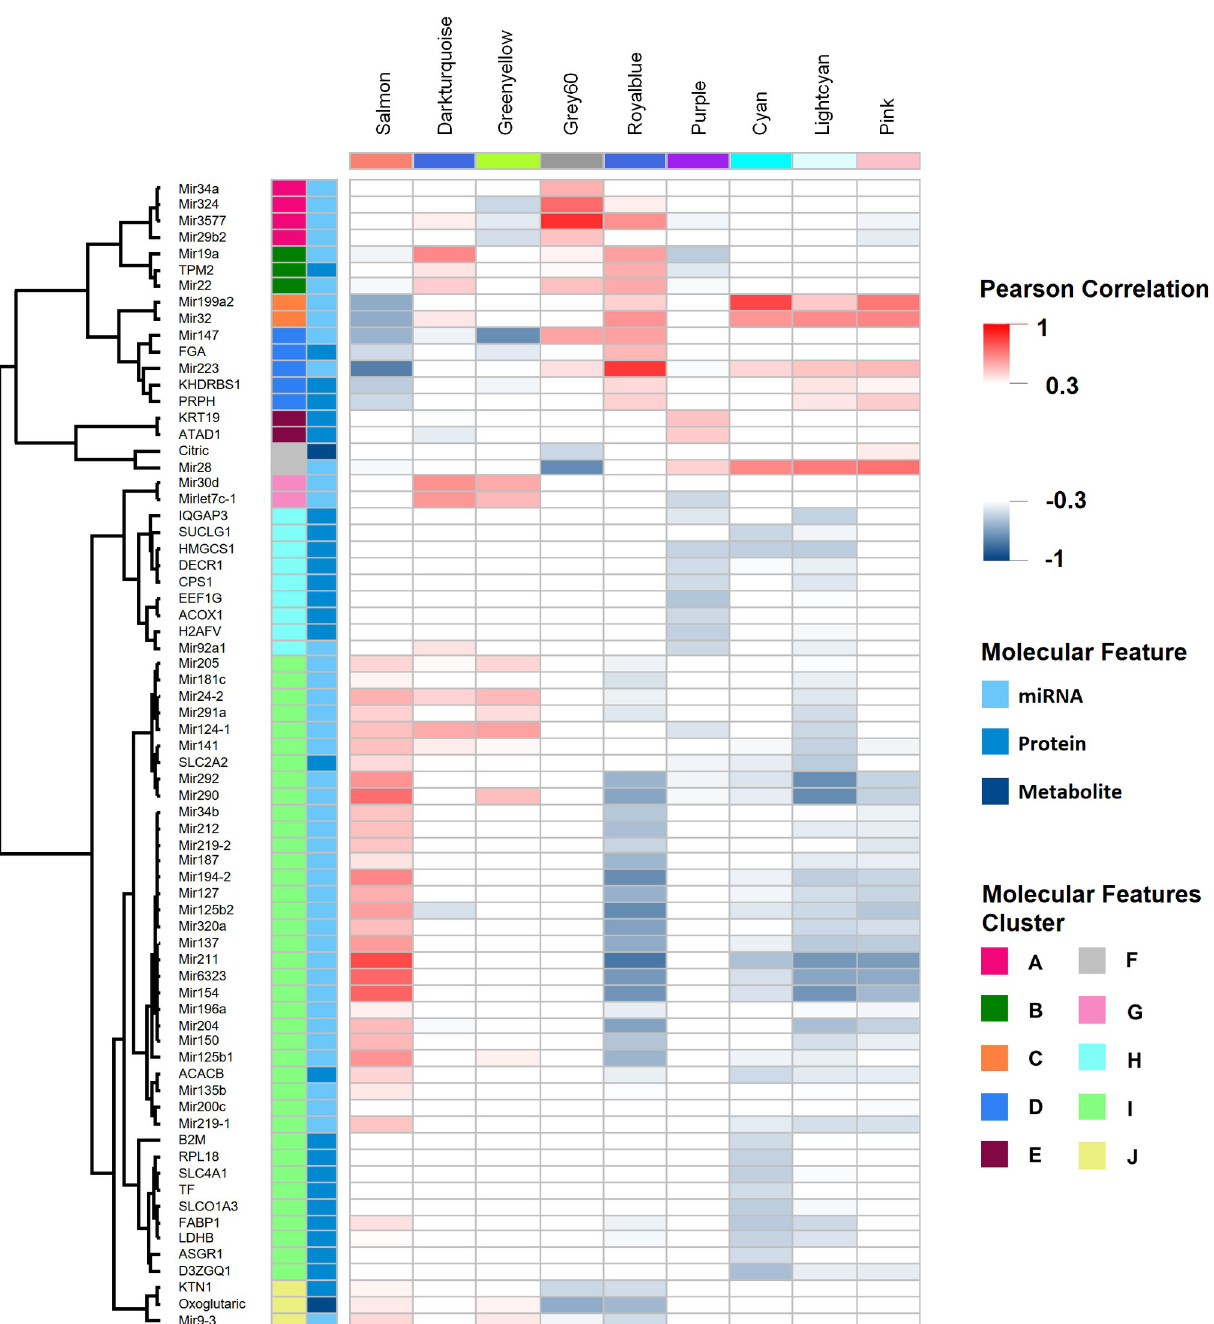
Fig 5. WGCNA-based omics integration is useful to identify hypothetical regulation mechanisms between biological levels. Nine modules of co- expressed genes were identified using WGCNA and correlated with profiles of miRNAS genes, proteins and metabolites (first column in blue scale) throughout HCC development; molecular features are shown in rows, molecular features were clustered (second column, colored clusters A-J) according to their expression profile using Pearson’s correlation. Only molecular features with a significant Pearson correlation > |0.40| and p < 0.001 are shown. Transcriptomic modules are shown in the top of each column. Negative correlated molecular features in the grid are shown in blue, while those positively correlated are shown in